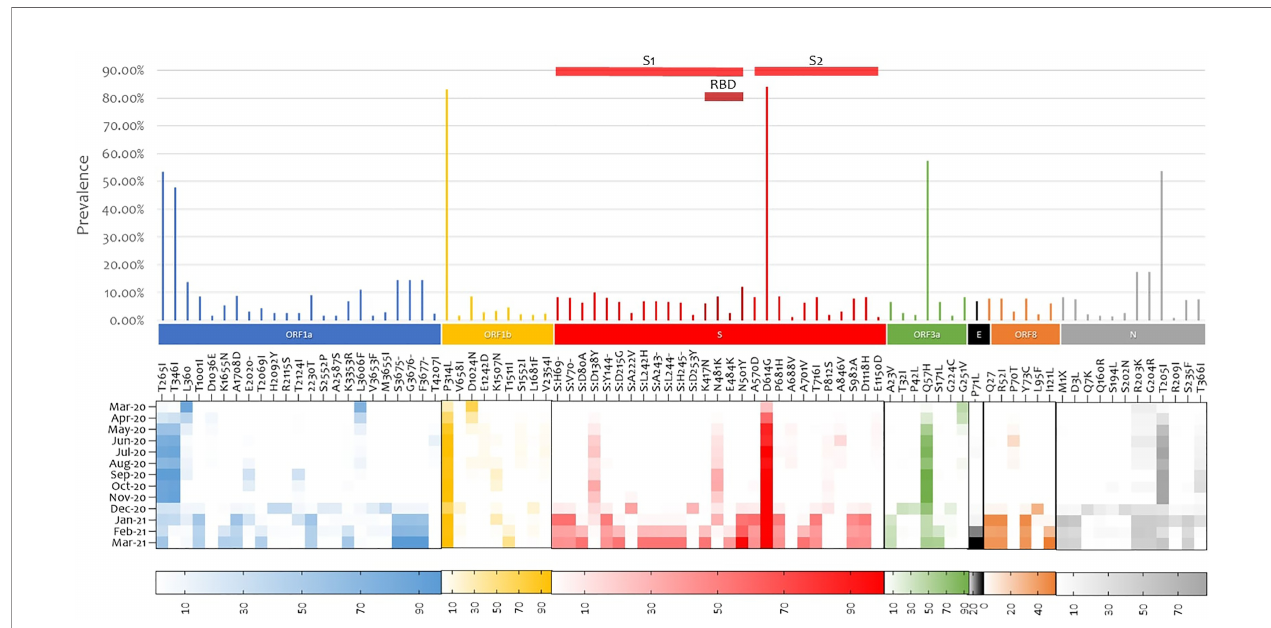
FIGURE 2 | Whole genome SARS-COV-2 mutation analysis. Mutations with at least 1% frequency are presented in bars and their evolution during the studied one- year period is presented in the heat map. SARS-COV-2 gene annotation is shown in colors. ORF, Open reading frame; S, Spike; E, Envelope; N, Nucleocapsid.